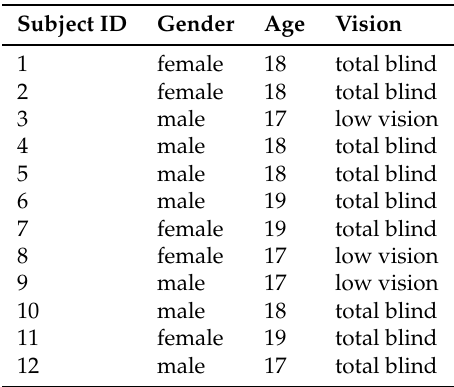
Table 4. Basic information of